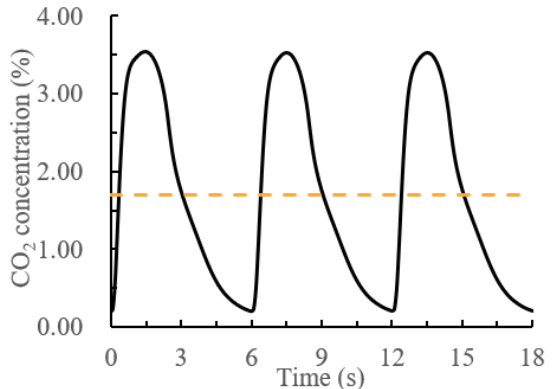
Figure A1. CFD simulated CO 2 concentration at the sampling tube of the central sampling case, where the solid black line represents the dynamic CO 2 concentration and the dashed orange line illustrates the time-average CO 2 concentration of 1.70%.